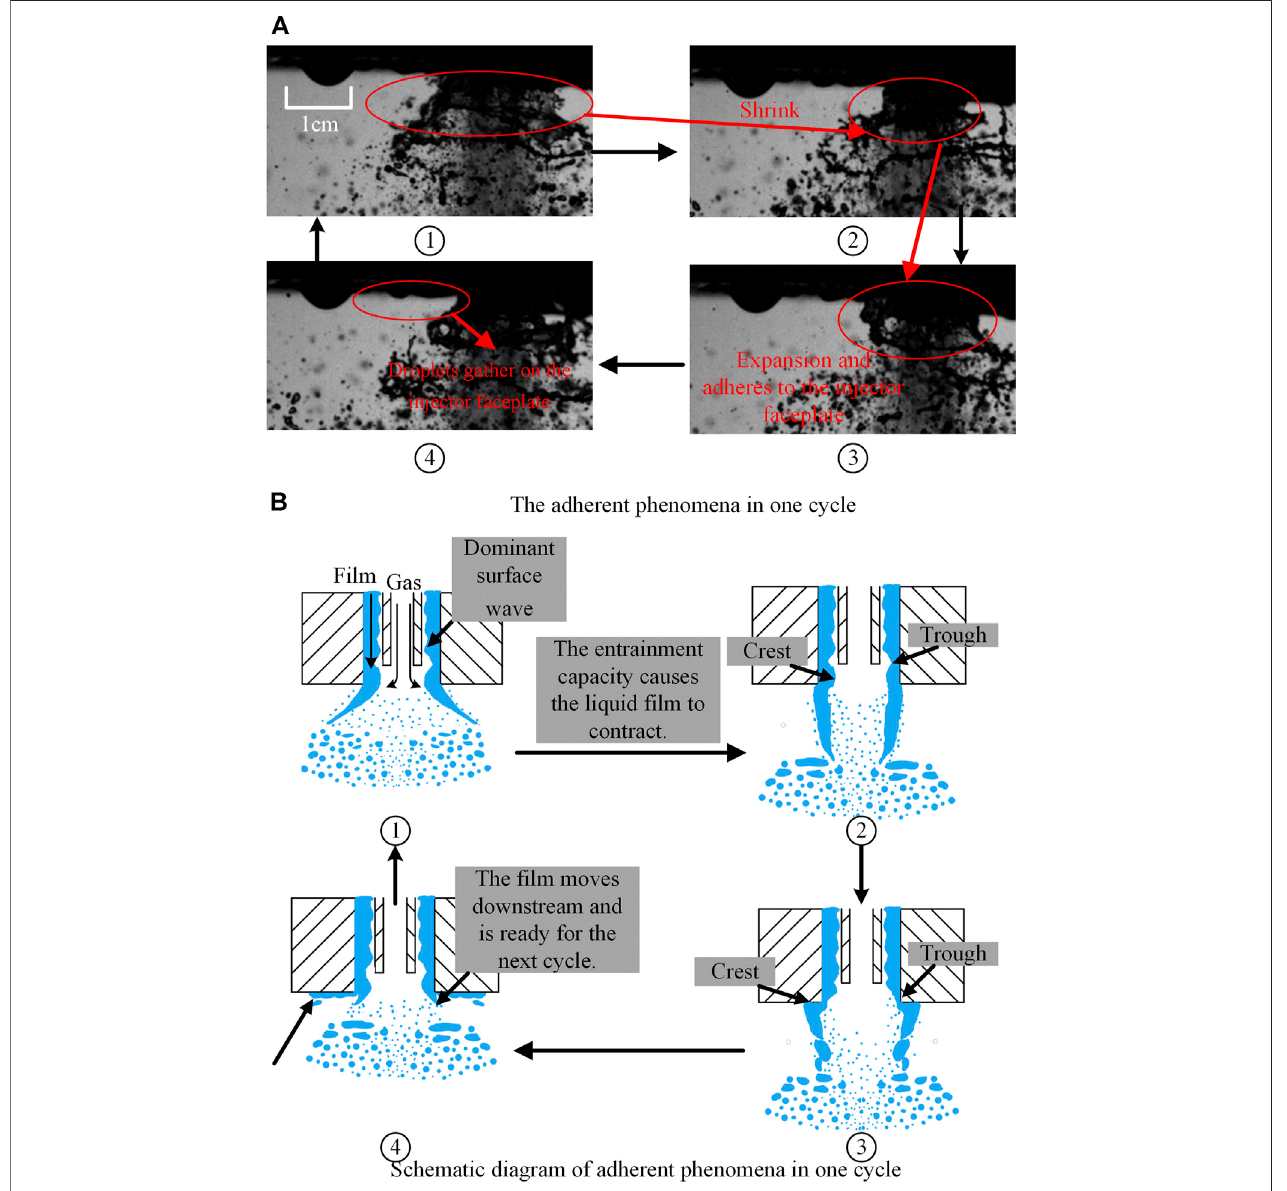
FIGURE13| Mechanism ofadherentphenomenawithsmallrecess. (A) Theadherentphenomenainonecycle. (B) Schematic diagramofadherent phenomenain one cycle.